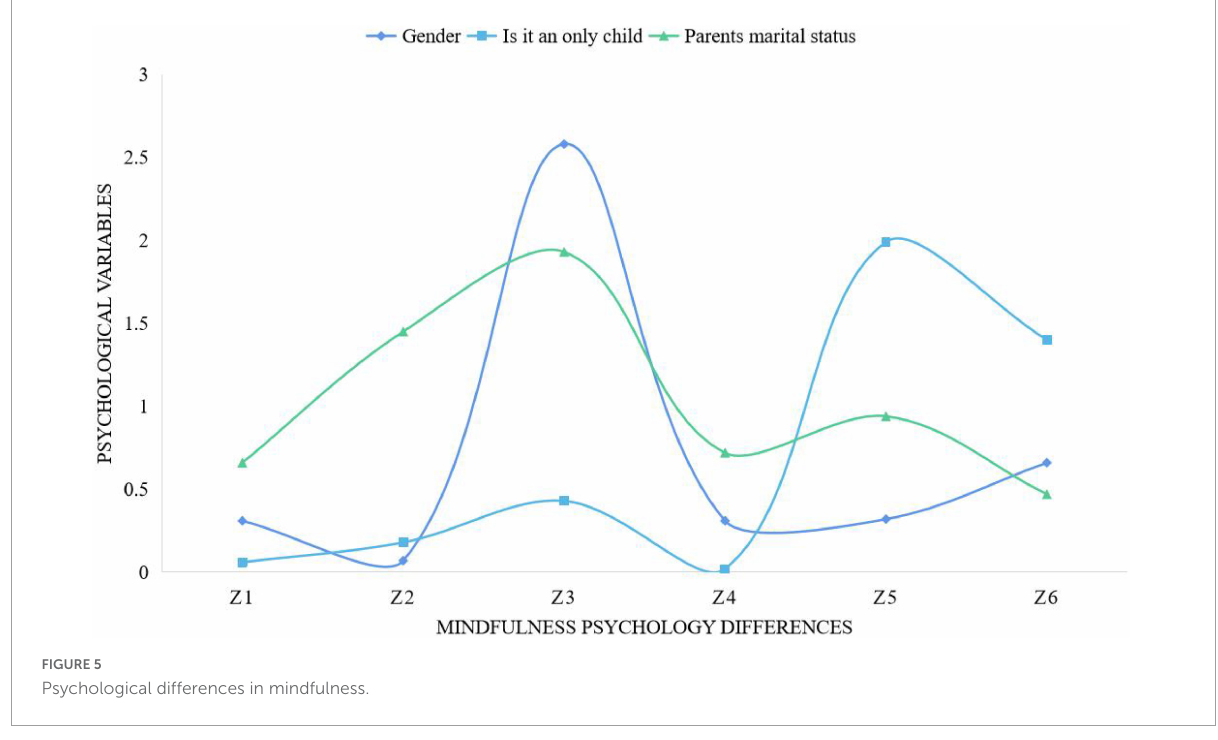
FIGURE5 Psychological differences in mindfulness.